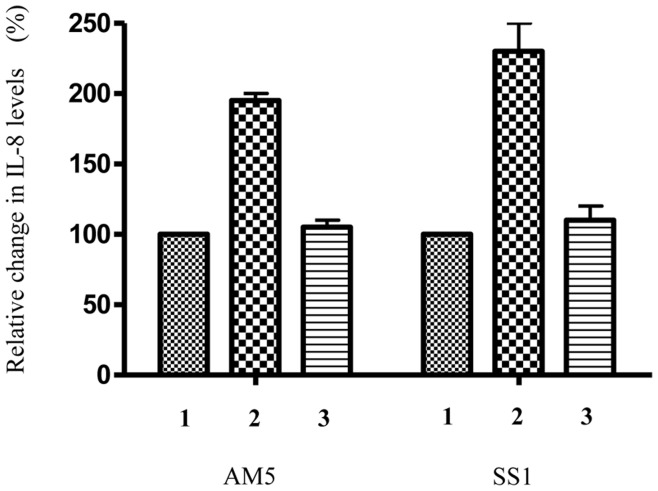

hpyAVIBM deletion enhances IL-8 production in AGS cell lines.(1) H. pylori strain AM5/SS1 (2) H. pylori strain AM5ΔhpyAVIBM/SS1ΔhpyAVIBM (3) hpyAVIBM deletion mutant AM5/SS1 complemented with hpyAVIBM from strain 26695.